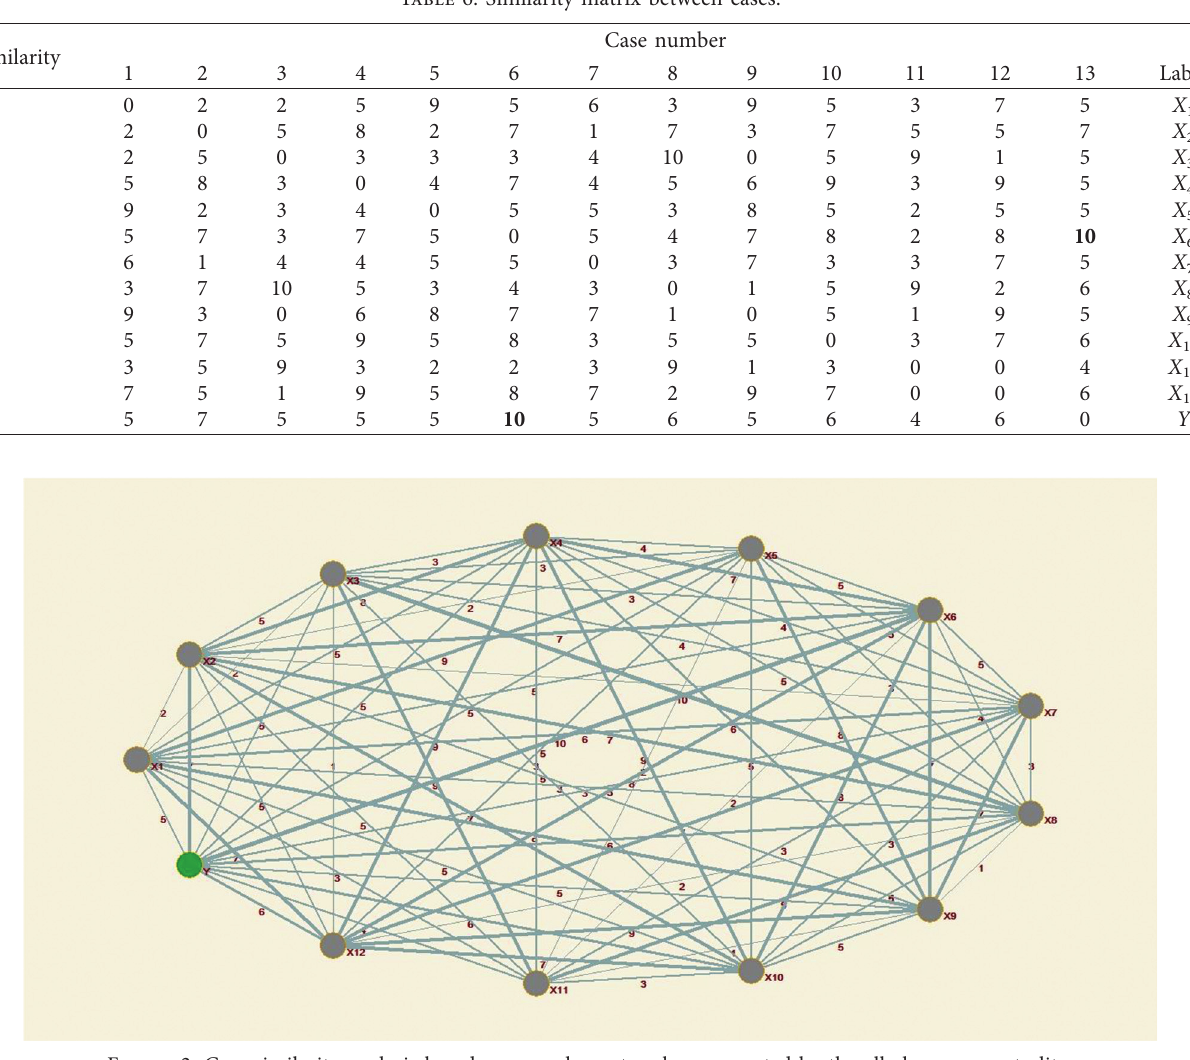
Table 6: Similarity matrix between cases.